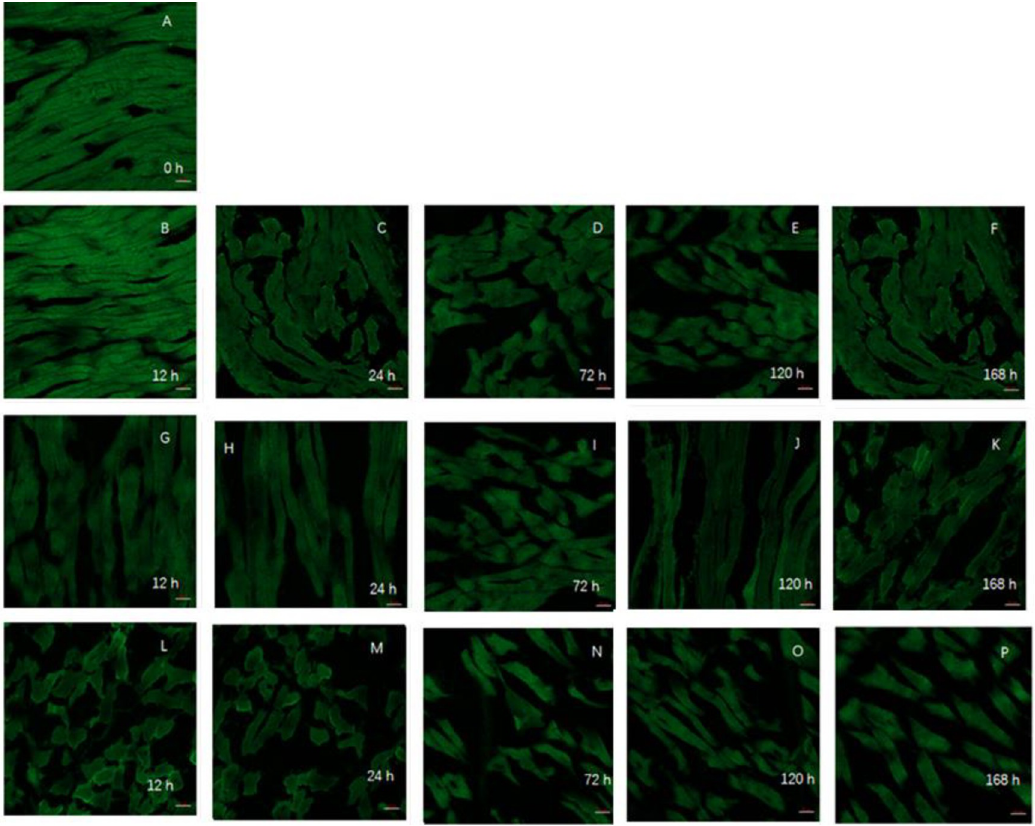
Fig 2. The morphological distribution of mitochondria in the muscle of the yak during postmortem maturation with a confocal laser microscope. The mitochondria are marked green by MitoTracker Green. A-F: at 0, 12, 24, 72, 120 and 168 h in the NAD + treatment group; G-K: at 12, 24, 72, 120 and 168 h in the blank control group; L-P: at 12, 24, 72, 120 and 168 h in NADH treatment